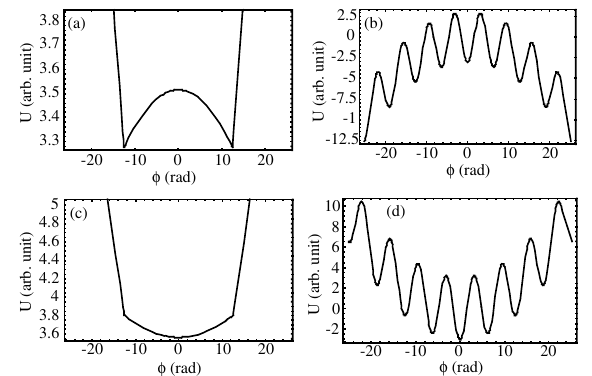
FIG. 4. Sketch of the potential for (a) the superbunch beam; (b) the rf-bunch beam before the transition energy; (c) the superbunch beam; (d) the rf-bunch beam after the transition (cid:4) 4 (cid:14) (rad); k (cid:4) (cid:5) 0 : 43 (cid:1) kV =(cid:22) s (cid:2) . energy. (cid:23) 0